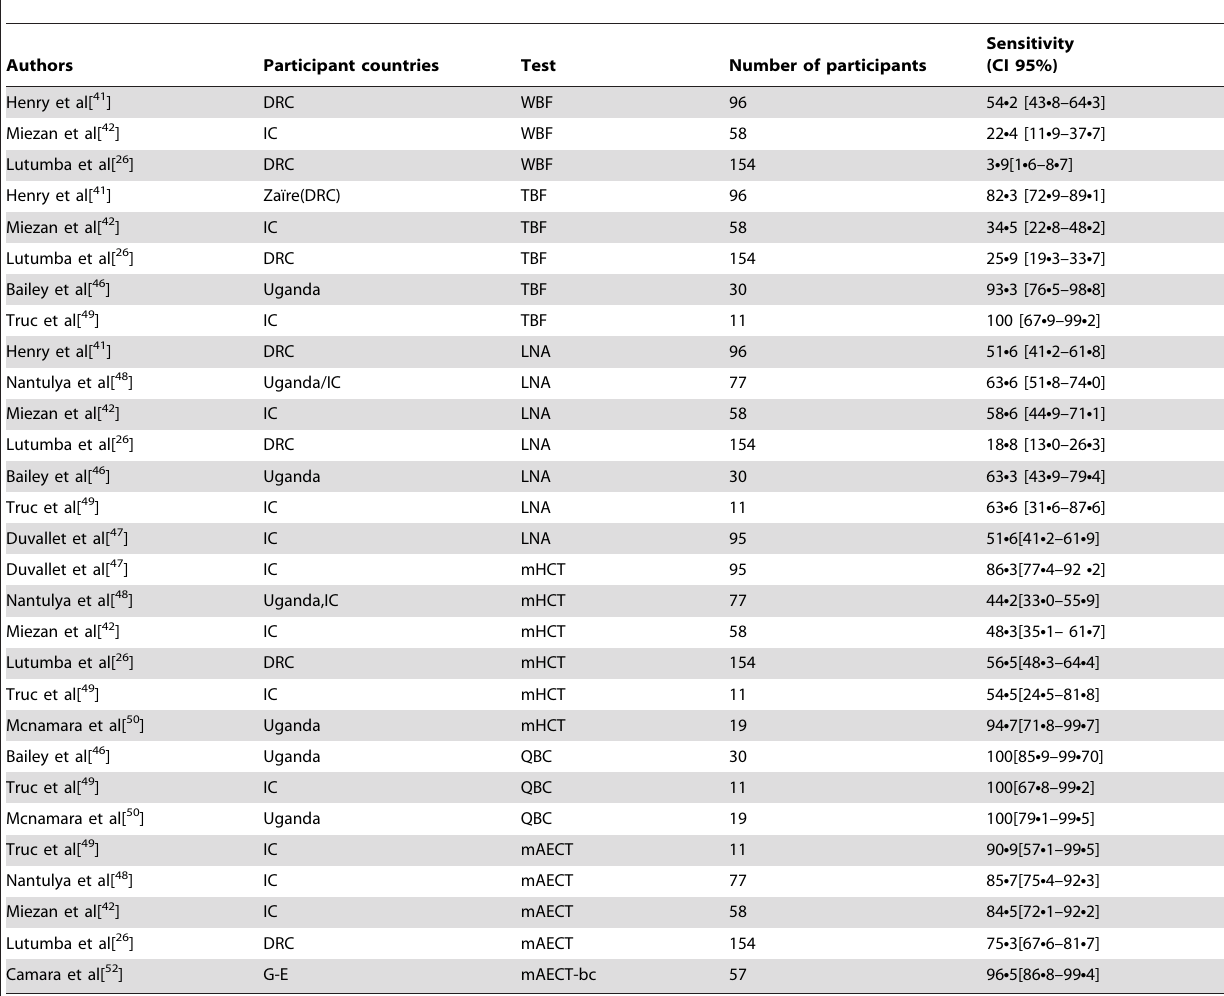
Table 2. Summary of published sensitivity estimates of parasite detection methods for